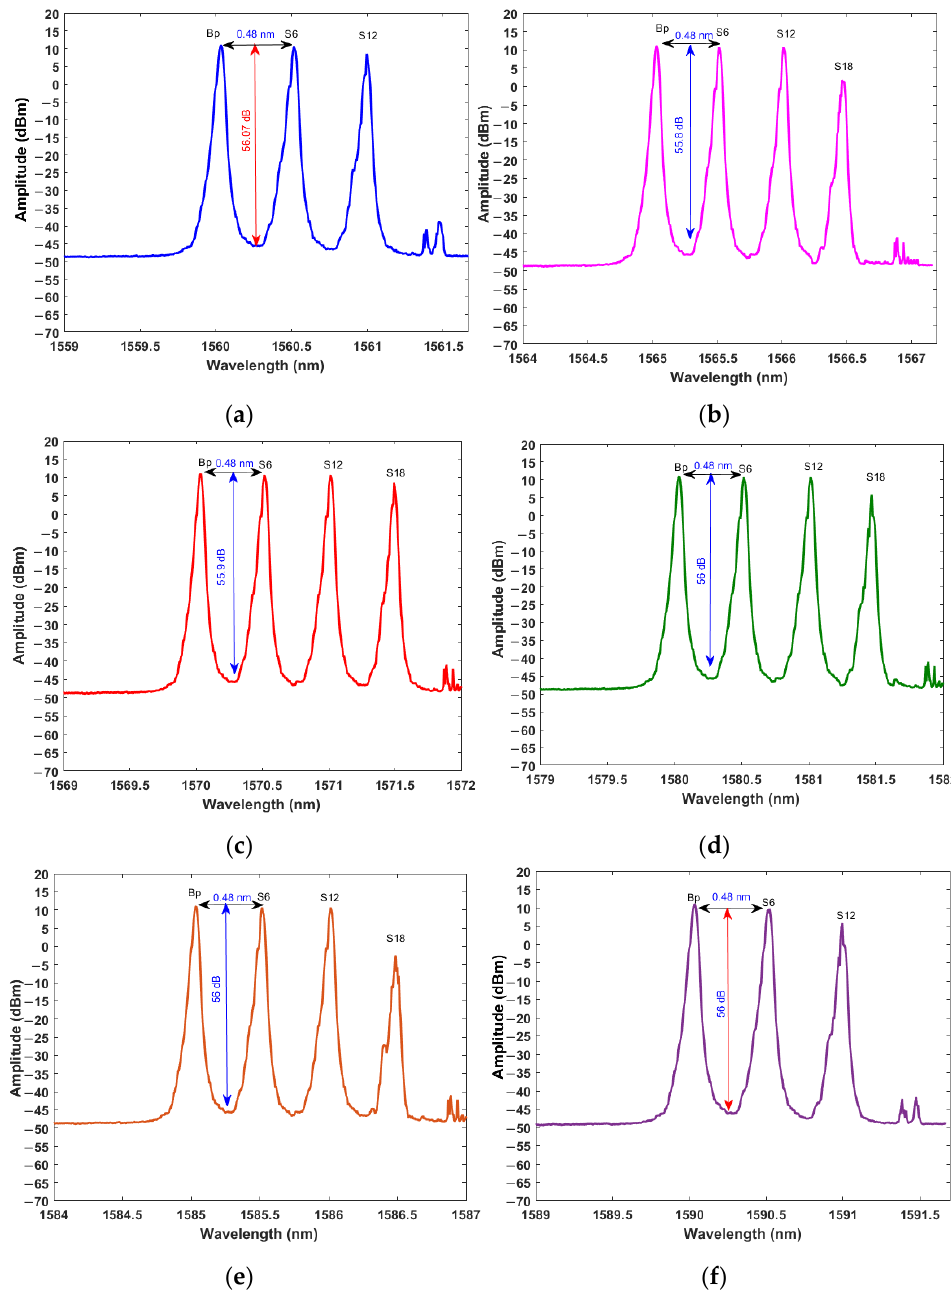
Figure 7. Different sextuple Stokes signal spectrums at Bp wavelengths of ( a ) 1560 nm, ( b ) 1565 nm, ( c ) 1570 nm, ( d ) 1580 nm, ( e ) 1585 nm, and ( f ) 1590 nm.